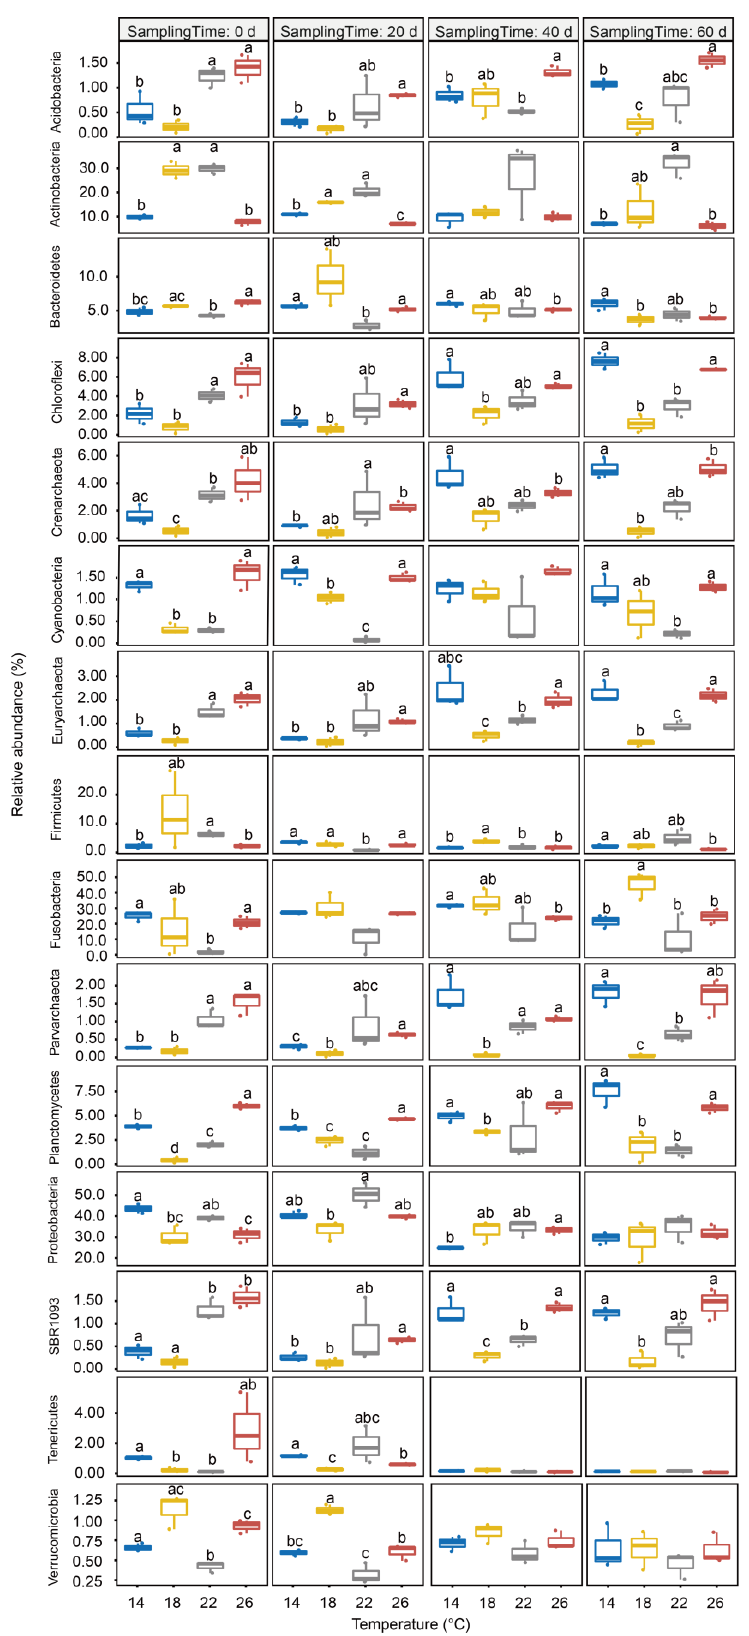
Figure 3. Relative abundance changes of commonly dominant phyla of Percocypris pingi gut microbiota at different culture temperatures. Dots in the boxplots indicate values measured in samples. Distinct letters above the boxes indicate significant differences ( p < 0.05).